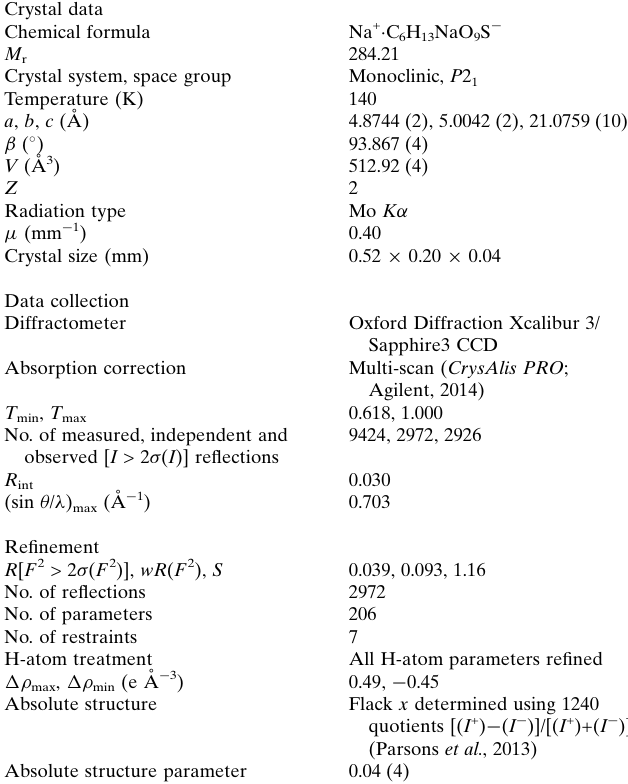
Crystal data Chemical